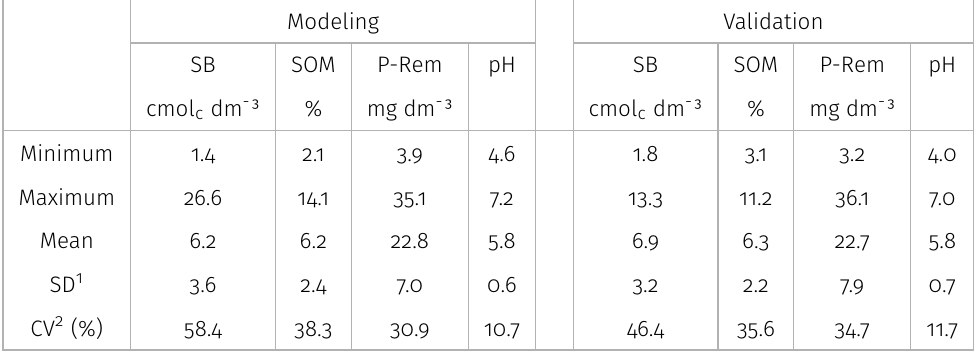
Table I. Descriptive statistics of the soil attributes: pH, sum of bases (SB), soil organic matter (SOM) and remaining phosphorus (P-Rem), obtained from laboratory analysis from soil samples collected at Lavras, Minas Gerais, Brazil. Modeling Validation SB SOM P-Rem pH SB